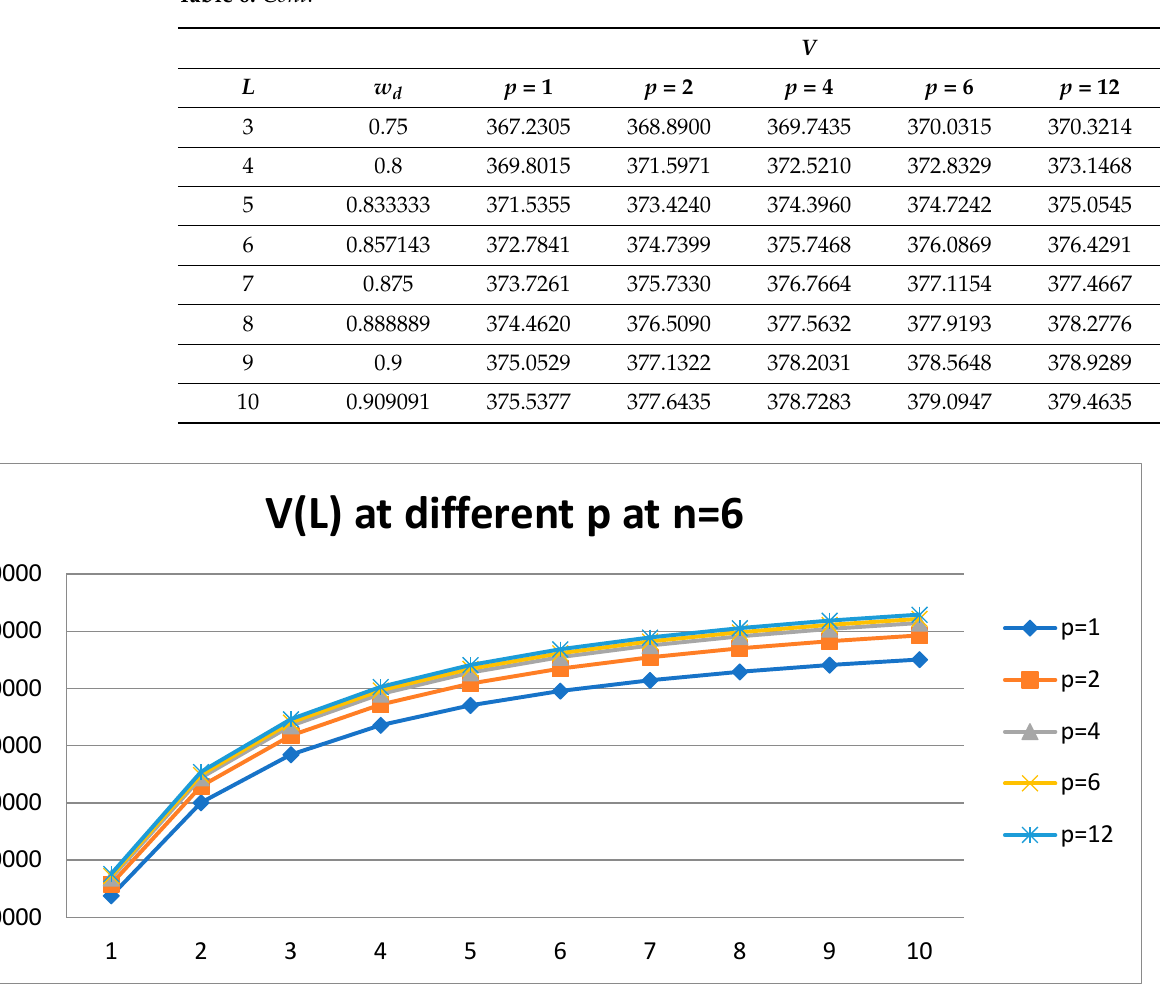
Table 7. Dependence of the equity cost, k e , on leverage level L at different frequency of payments of tax on profit p for six-year company.